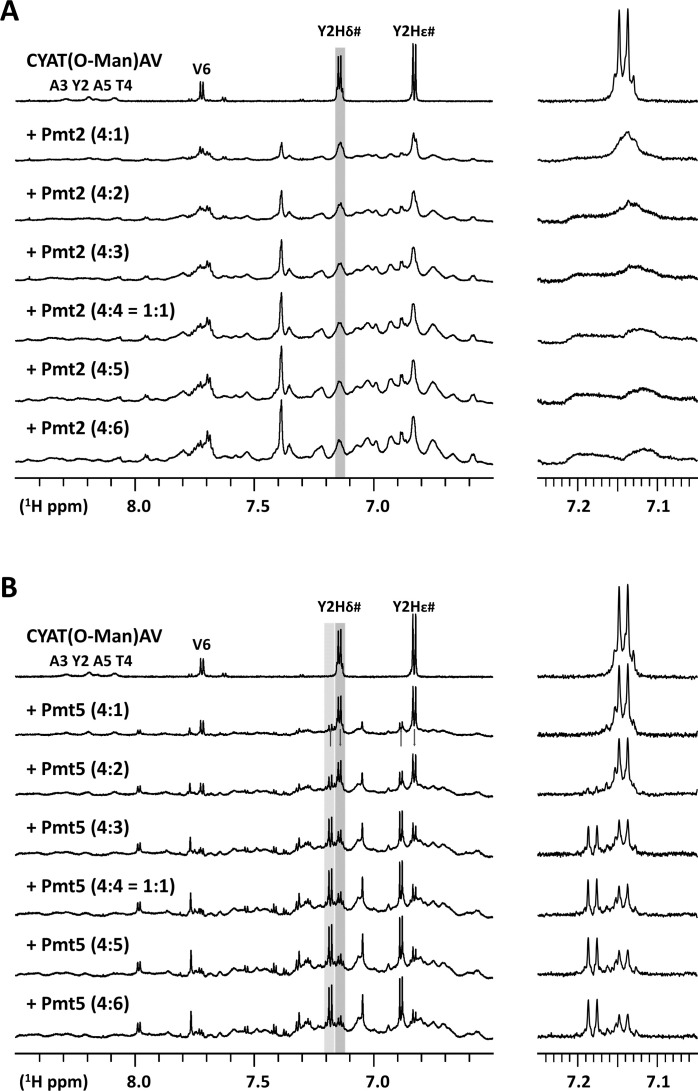
Interaction of Pmt2-MIR (A) and Pmt5-MIR (B) with the CYAT(O-Man)AV peptide.(A) The Pmt2-MIR domain strongly binds the CYAT(O-Man)AV peptide. Titration (1D 1H NMR) of the CYAT(O-Man)AV peptide with Pmt2 protein to a 1.5 times excess (4:6). The proton 1D spectra on the left shows the amide and aromatic region. The signals from Pmt2-MIR come up while the signals of the peptide broaden out and disappear upon addition of the protein as also visualized by the expanded region on the right showing the disappearance of the peptide Tyr-2 Hδ# signal (after background-subtraction of a blank apo-Pmt2 spectrum of the same concentration). (B) The Pmt5-MIR domain binds the CYAT(O-Man)AV peptide in slow exchange. Titration (1D 1H NMR) of the CYAT(O-Man)AV peptide with Pmt5-MIR protein to a 1.5 times excess (4:6). The proton 1D spectra on the left shows the amide and aromatic region. The signals from Pmt5-MIR come up while the aromatic tyrosine signals of the peptide disappear and appear at a new position upon addition of the protein as also visualized by the expanded region on the right showing the peptide Tyr-2 Hδ# signal (after background-subtraction of a blank apo-Pmt5-MIR spectrum of the same concentration).